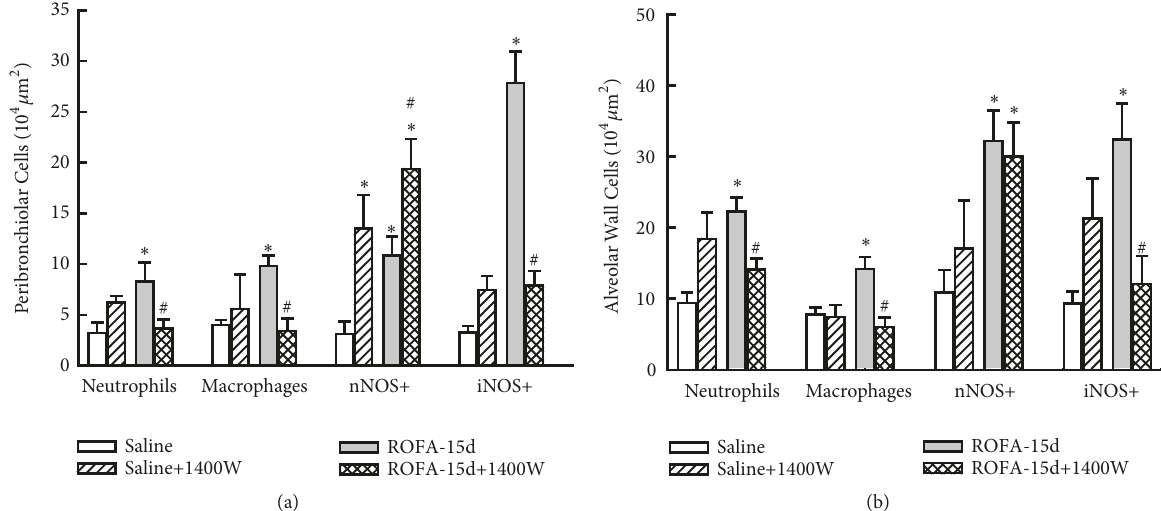
Figure 2: Lung inflammation and nitric oxide synthase expression. This figure represents the mean and SEM values of macrophages, neutrophils, nNOS, and iNOS-positive cells in peribronchiolar (a) and alveolar (b) wall. The animals that received fifteen instillations of ROFA presented higher values of all cells, and 1400W reduced inflammation and iNOS-positive cells, not interfering with nNOS expression. ∗ p < 0.05 compared with saline groups; # p < 0.05 compared with animals that received ROFA and vehicle treatment.